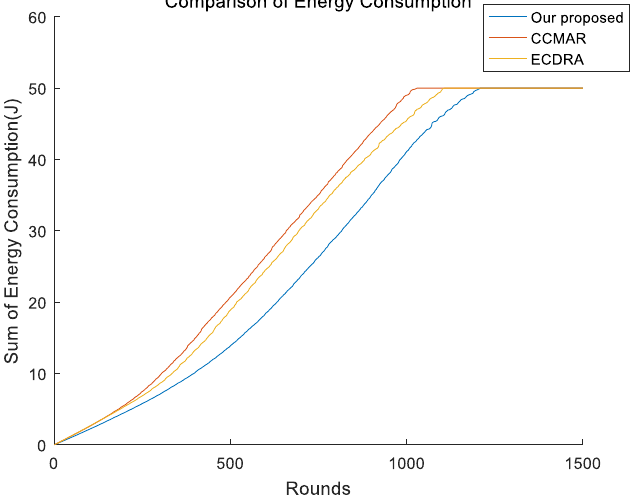
Figure 7. Comparison of the network lifetime between different algorithms.